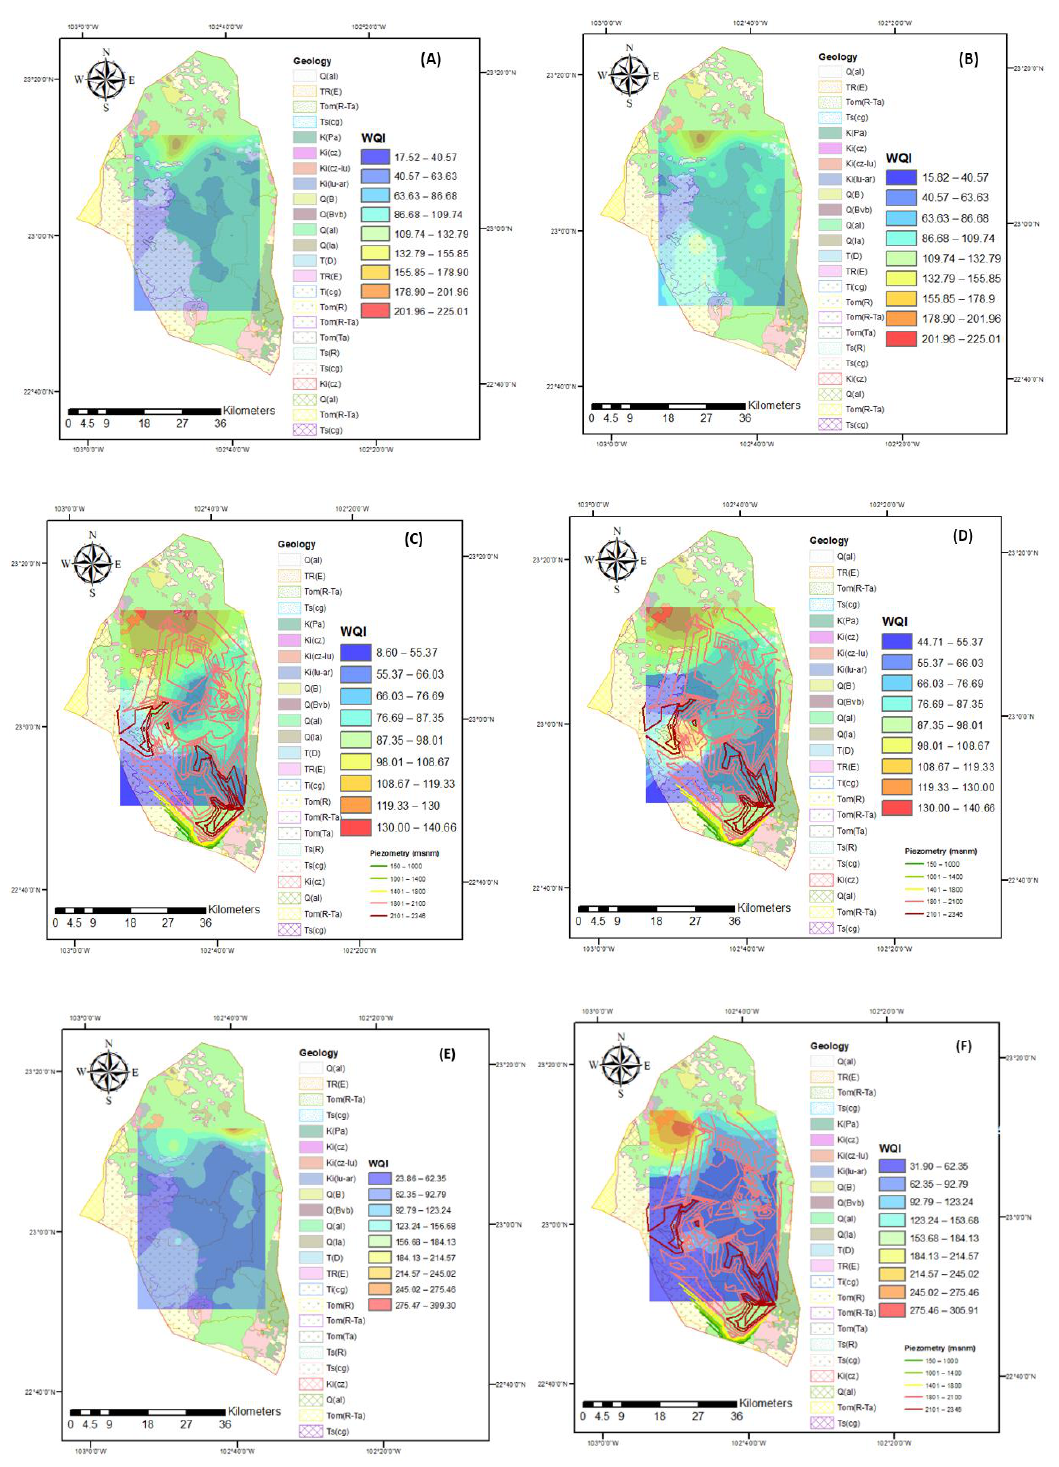
Figure 7. WQI calculated considering different parameters in the Calera aquifer sampling area: ( A ) WQI without considering arsenic in 2005; ( B ) WQI considering arsenic in 2005; ( C ) WQI without considering arsenic in 2015; ( D ) WQI considering arsenic in 2015; ( E ) WQI considering arsenic and fluor in 2005; ( F ) WQI considering arsenic and fluor in 2015.